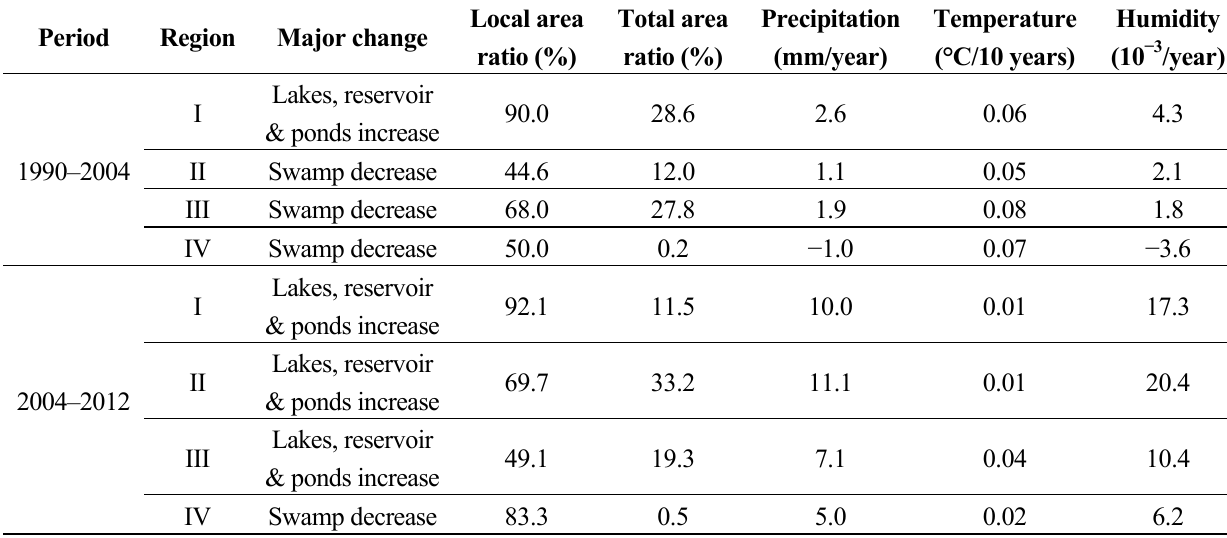
Table 4. The relativity statistics between wetland and climate changes in the TRH region from 1990 to